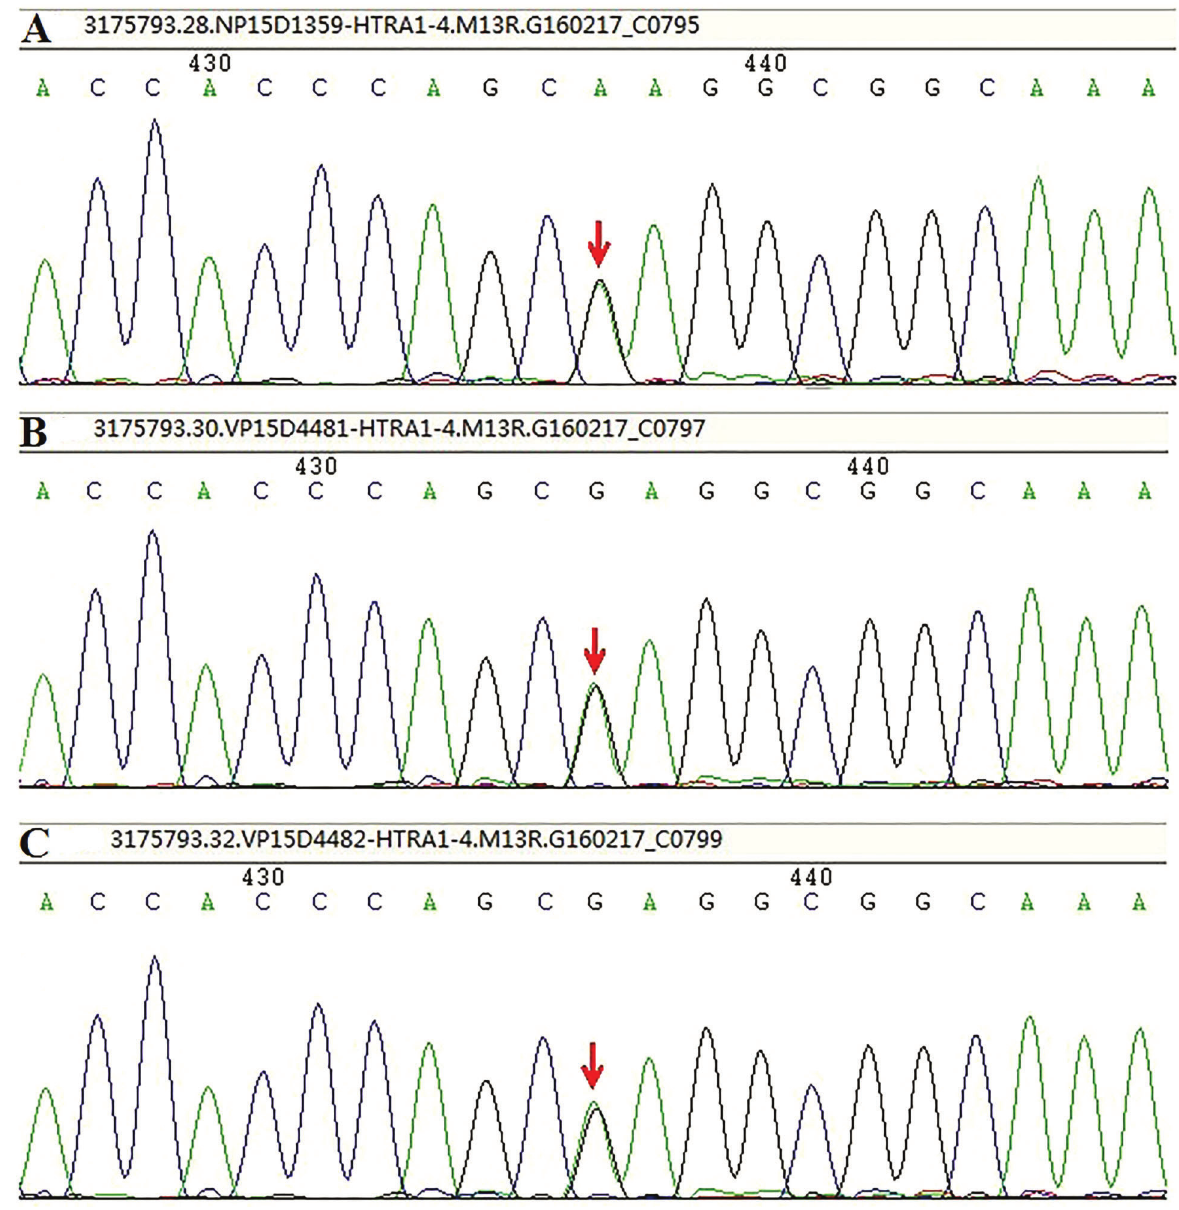
Figure 5. Single nucleotide polymorphism sequencing of candidate genes. Graphs show the c.905g 4 A Heterozygous mutation in of the HTRA1 gene of the ( A ) pro-band (III10), ( B ) pro-band ’ s eldest sister (III6) and ( C ) the pro-band ’ s third sister